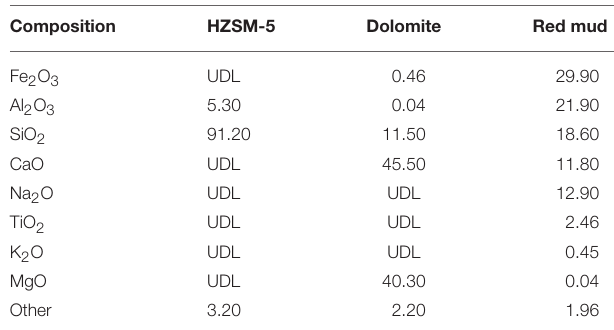
TABLE 2 | XRF analysis of the catalyst